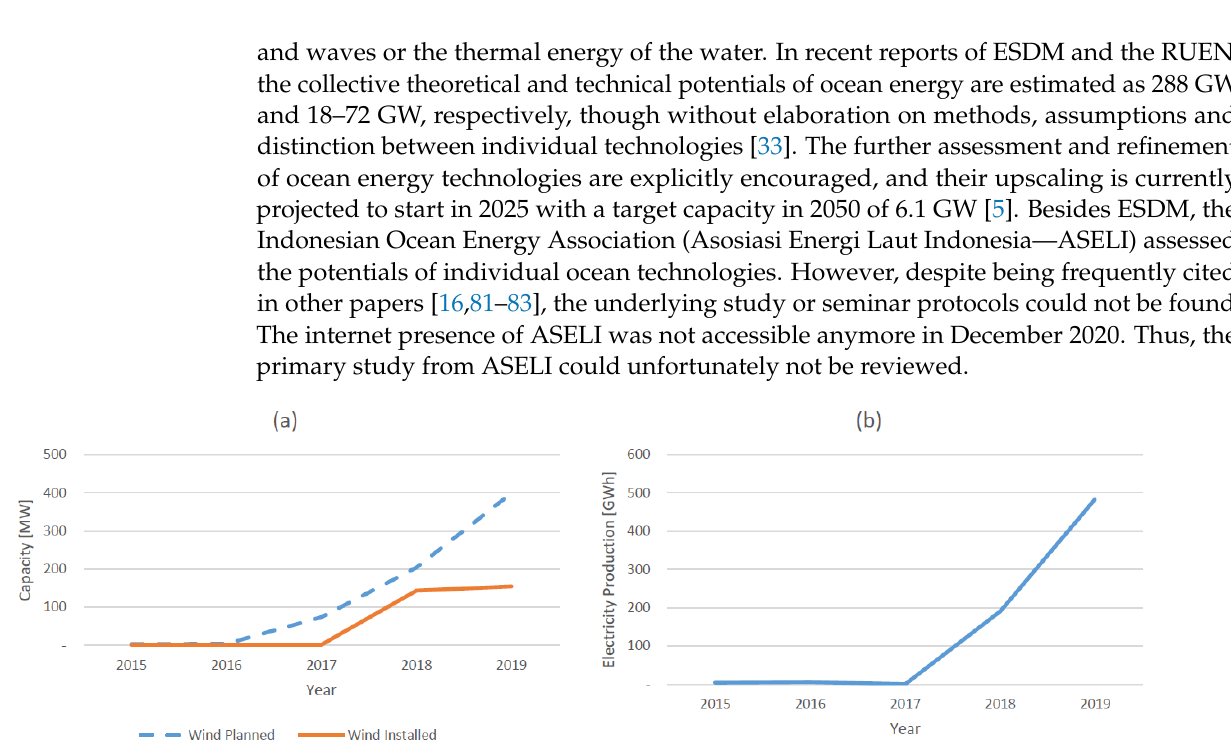
Figure 6. ( a ) Planned vs. installed wind capacity. ( b ) Electricity production from wind power [2,5].